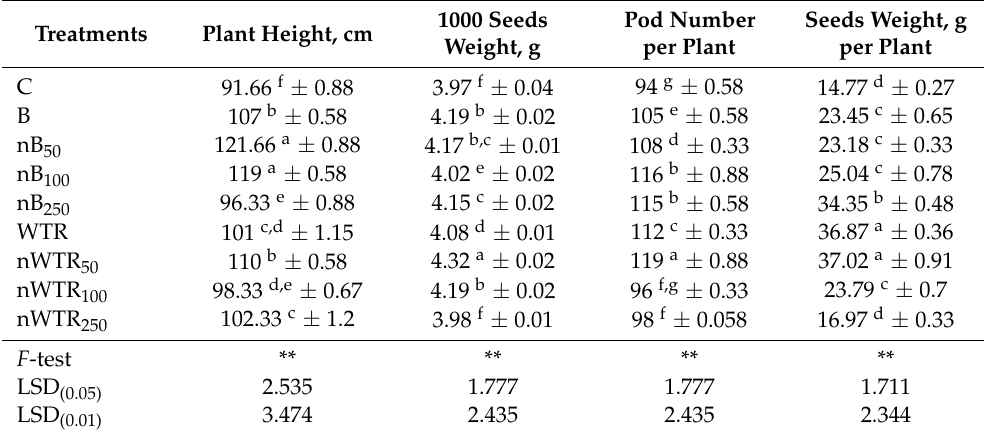
Table 3. Effect of nanoparticles of biochar (nB) and water treatment residuals (nWTR) on canola productivity.